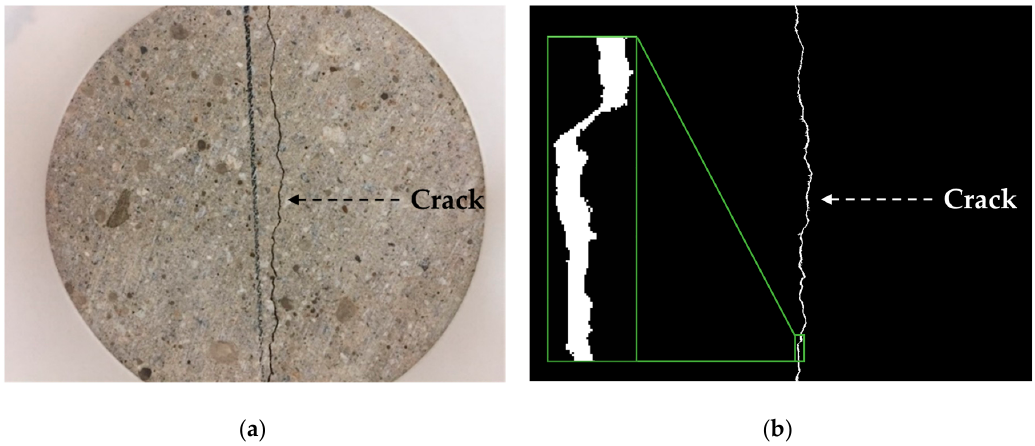
Figure 3. Crack width measurement using image binarization technique: ( a ) Original RGB image; ( b ) Binary image.